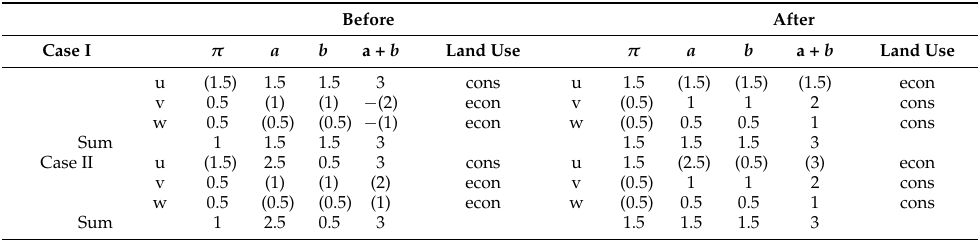
Table 1. Example of a bundled credits trade, involving three land parcels (u, v, w; in lines) each of which can be used economically (econ) or for conservation (cons); and under economic use earns a profit π and under conservation generates ecosystem services a and b . Numbers in parentheses give the profit or ecosystem service (ES) if the land parcel is used economically or for conservation, respectively; under the respective other land use the profit or ES, respectively, is zero. The last line shows the total profit and ecosystem services generated by the land use. Two cases, case I and case II, are considered and the left half of the table represents the situation before the land-use change and the right half represents the situation after the land-use